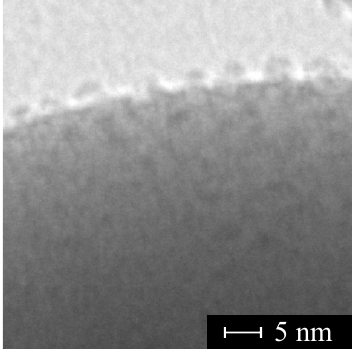
Figure 12. The transmission electron micrographs of the individual Mn 12 -stearate molecules attached to the spherical silica